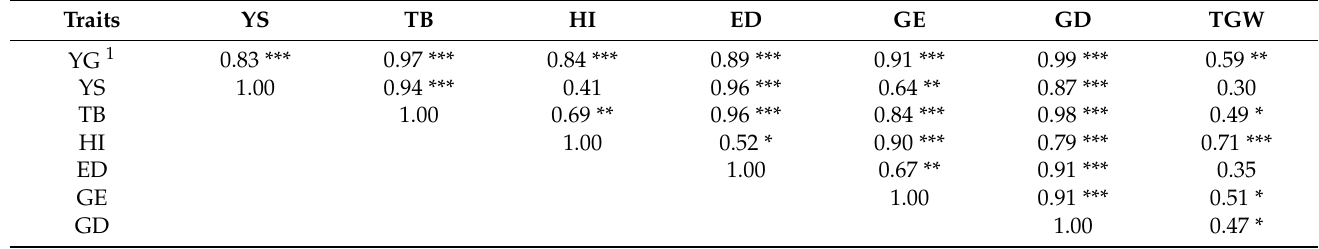
Table A1. Matrix of correlation indices for grain yield winter wheat and its components, n = 21.